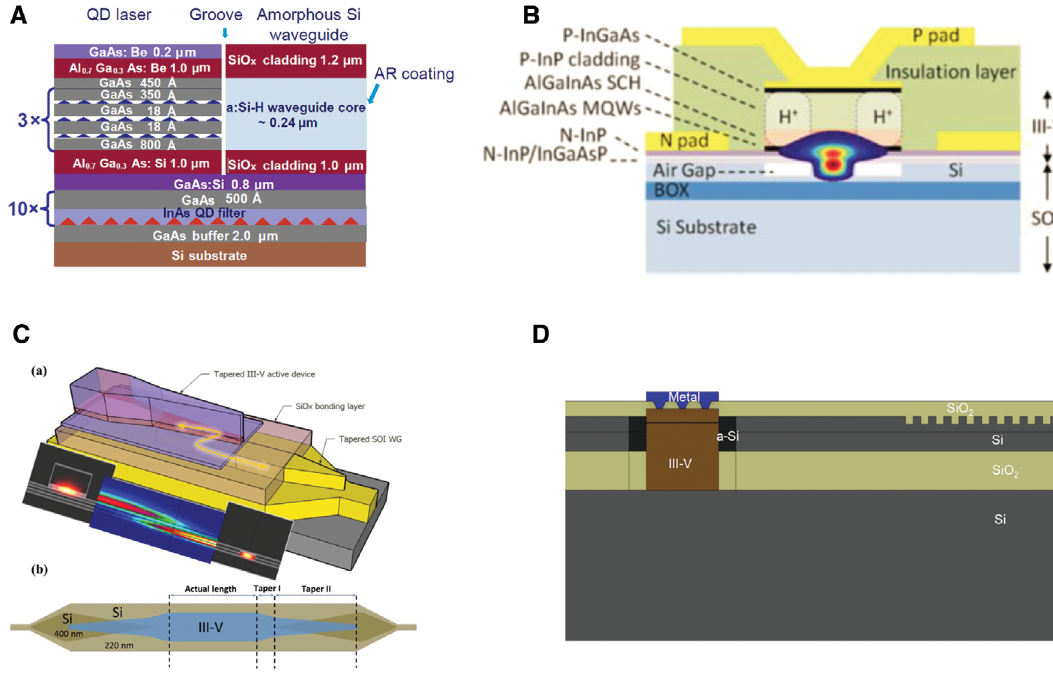
Figure 6 Schematics of four heterogeneous approaches to integrate III–V laser on Si substrates: (A) monolithic epitaxial growth of InGaAs/ GaAs quantum-dot regions buffered by 10 layers of inactive dots to filter propagation of threading dislocations into the active region [72]; (B) evanescently-coupled InP lasers bonded on SOI waveguides [73]; (C) tape-waveguide vertical coupling form III–V gain regions into SOI [74]; and (d) bonding III–V gain regions into trenches made in silicon for planar coupling between the two